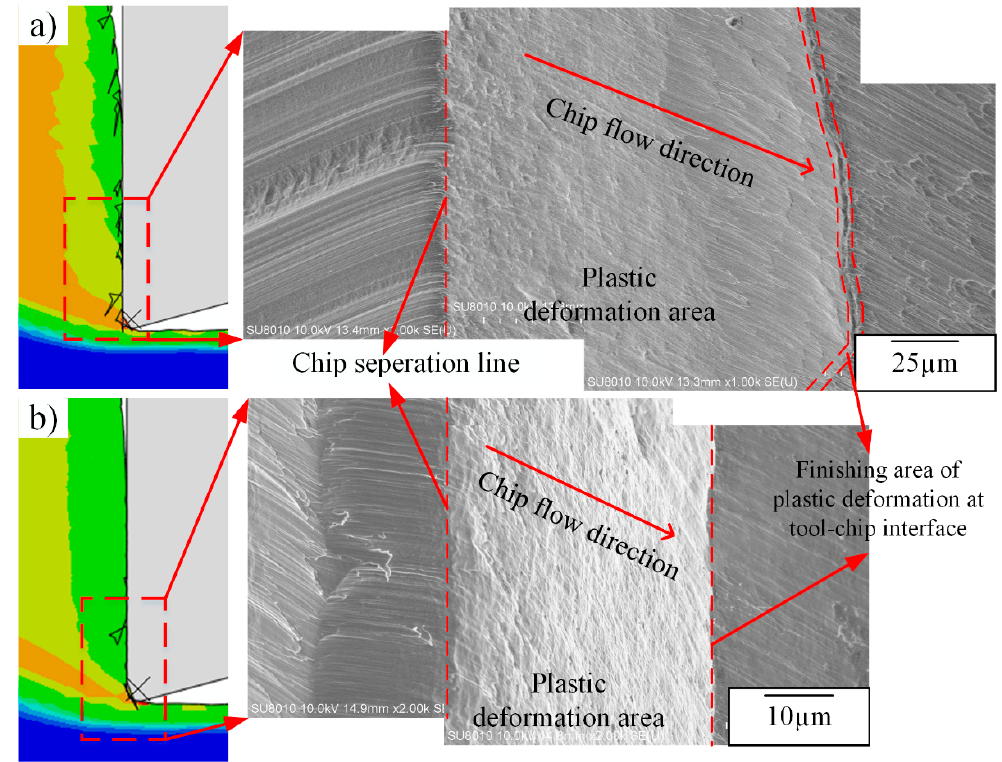
Figure 15. Fracture characteristics during chip separation at different cutting speeds, ( a ) 750m/min and ( b ) 1500m/min.